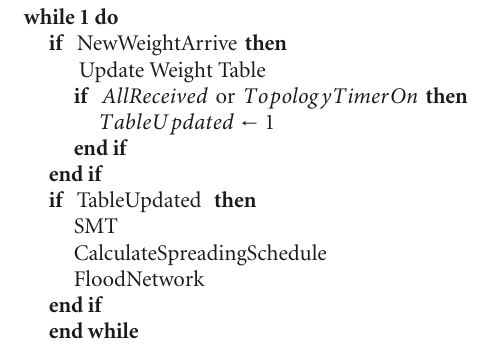
Algorithm 1: Gateway procedure